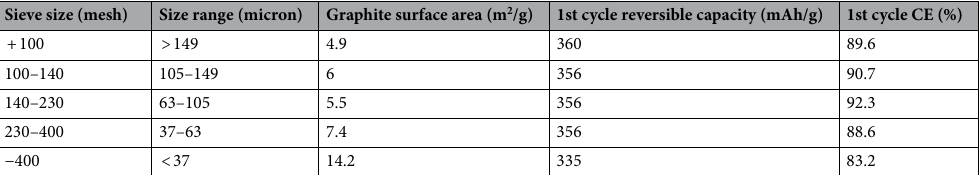
Table 1. Sawdust sizes after sieving, the resulting graphite surface area and the 1st cycle gravimetric capacity and CE of Li-ion anodes made from the BCG samples.